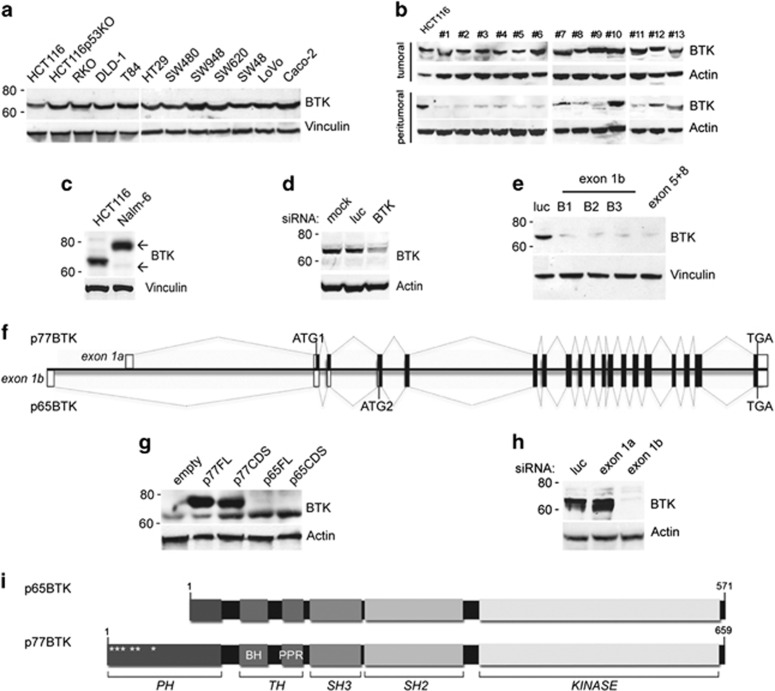
p65BTK, a novel isoform of Bruton's tyrosine kinase, is widely expressed in colon carcinoma cell lines and tissues. (a, b) BTK expression in colon cancer cell lines (a) or patients' biopsy (b) lysates. Western blots probed with a commercial BTK antibody (Santa Cruz, sc-1696). (c) Western blot showing that in colon carcinoma cells (HCT116) BTK has a lower molecular weight than in lymphoid leukaemia (Nalm-6). (d) Western blot of BTK expression in HCT116 cells after silencing with BTK-specific siRNA (exons 5+8). (e) Western blot of BTK expression in HCT116 cells upon silencing using exon 1b (B1–3)-targeting siRNAs. (f) BTK gene and mRNAs encoding p77BTK and p65BTK. ATG1 and ATG2: start codons, black/white boxes: translated/untranslated exons. Exon 1a and exon 1b are indicated. (g) BTK expression in 293T cells transiently transfected with empty vector (empty) and plasmids encoding p77BTK or p65BTK coding sequence (p77CDS, p65CDS), p77BTK CDS or p65BTK CDS full lengths (p77FL, p65FL). (h) Western blot of p65BTK expression in 293T cells transiently transfected with p65FL plasmid followed by silencing with exon1b-specific siRNAs. (i) p65 and p77 BTK protein organization: PH domain. BH, BTK homology region; PPR, PolyProline region; TH, Tec homology domain; *phosphoinositide binding site.